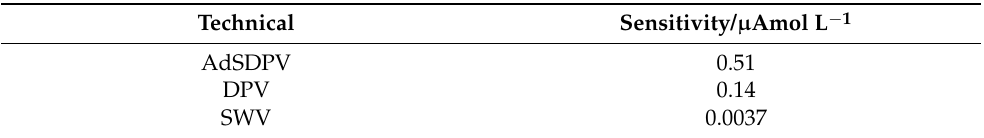
Table 1. Influence of electrochemical techniques in the determination of TC under optimized condi-